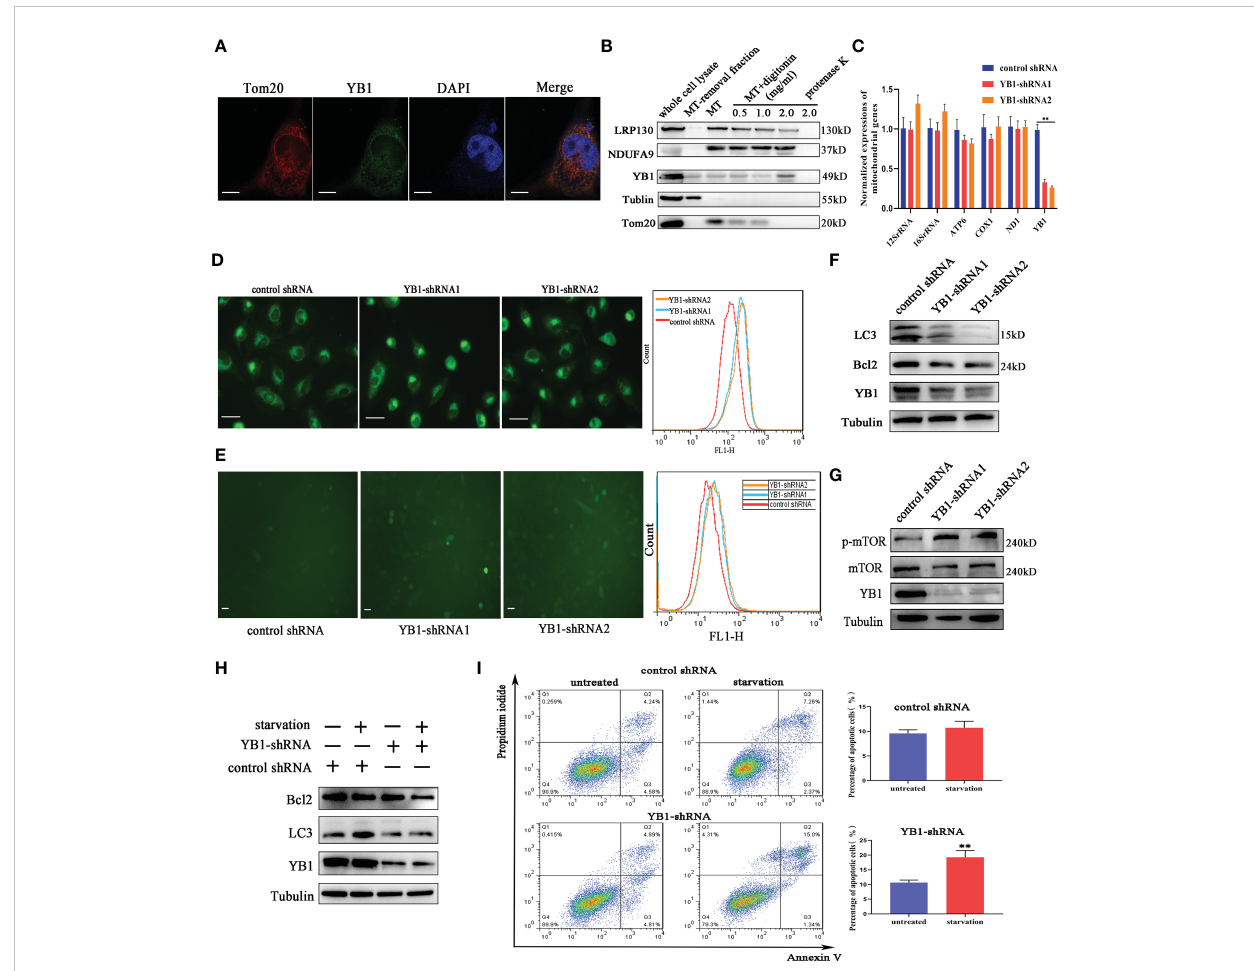
FIGURE 3 YB1 participated in balancing autophagy and cell apoptosis. (A) The co-localization of YB1 (green) with mitochondria (red) in breast cancer cells. Mitochondria were marked with TOM20 (red), and nuclei were stained with DAPI. Scale bars, 5 m m. (B) The protein level of YB1 in different mitochondrial fractions. Digitonin dose-dependently dissolved the mitochondrial outer membrane. The residual proteins were digested with protease K NDUFA9, inner membrane protein marker; LRPPRC, mitochondrial matrix localized protein. (C) Relative expressions of mitochondrial genome-encoded genes. The experiment was repeated three times. **p < 0.01. (D) The activity of mitochondria was investigated using fl ow cytometry. Mitochondria were labeled with MitoTracker dye; the fl uorescence signal intensity was analyzed. Scale bar, 10 m m. (E) The in fl uence of YB1 knockdown on cellular reactive oxygen species. Scale bar, 10 m m. (F) YB1 knockdown reduced the cellular basic autophagy level in breast cancer cells. (G) The mTOR signaling pathway was activated in cells with deleted YB1. (H, I) YB1-silenced expression failed to induce autophagy under starvation but signi fi cantly increased cell